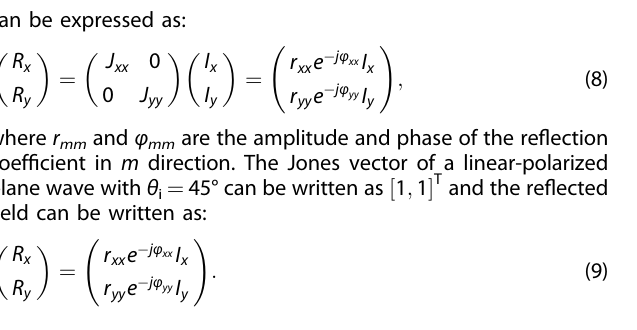
Fig. 4 Polarization state in the Poincaré sphere. Four typical polarization states with different linear polarization angles marked in the Poincaré sphere. The surrounding four pictures are the x and y components of related simulated electric fi elds with four different R g of a 50 Ω □ − 1 , b 300 Ω □ − 1 , c 550 Ω □ − 1 , and d 800 Ω □ − 1